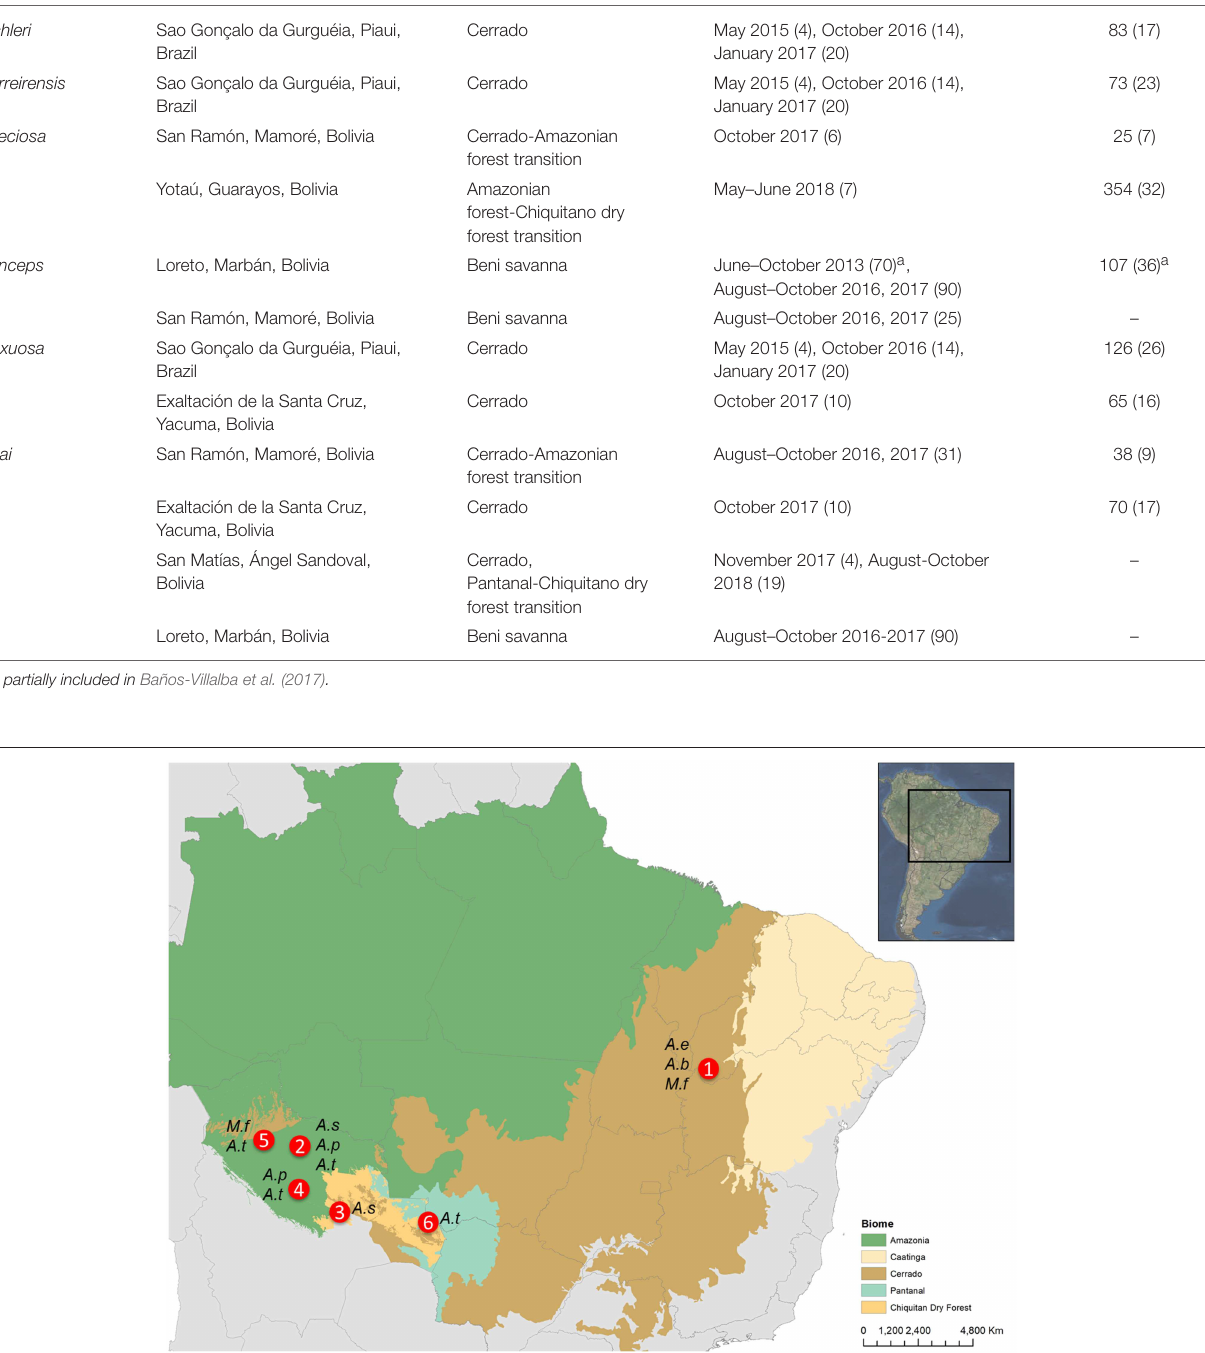
Frontiers in Ecology and Evolution |